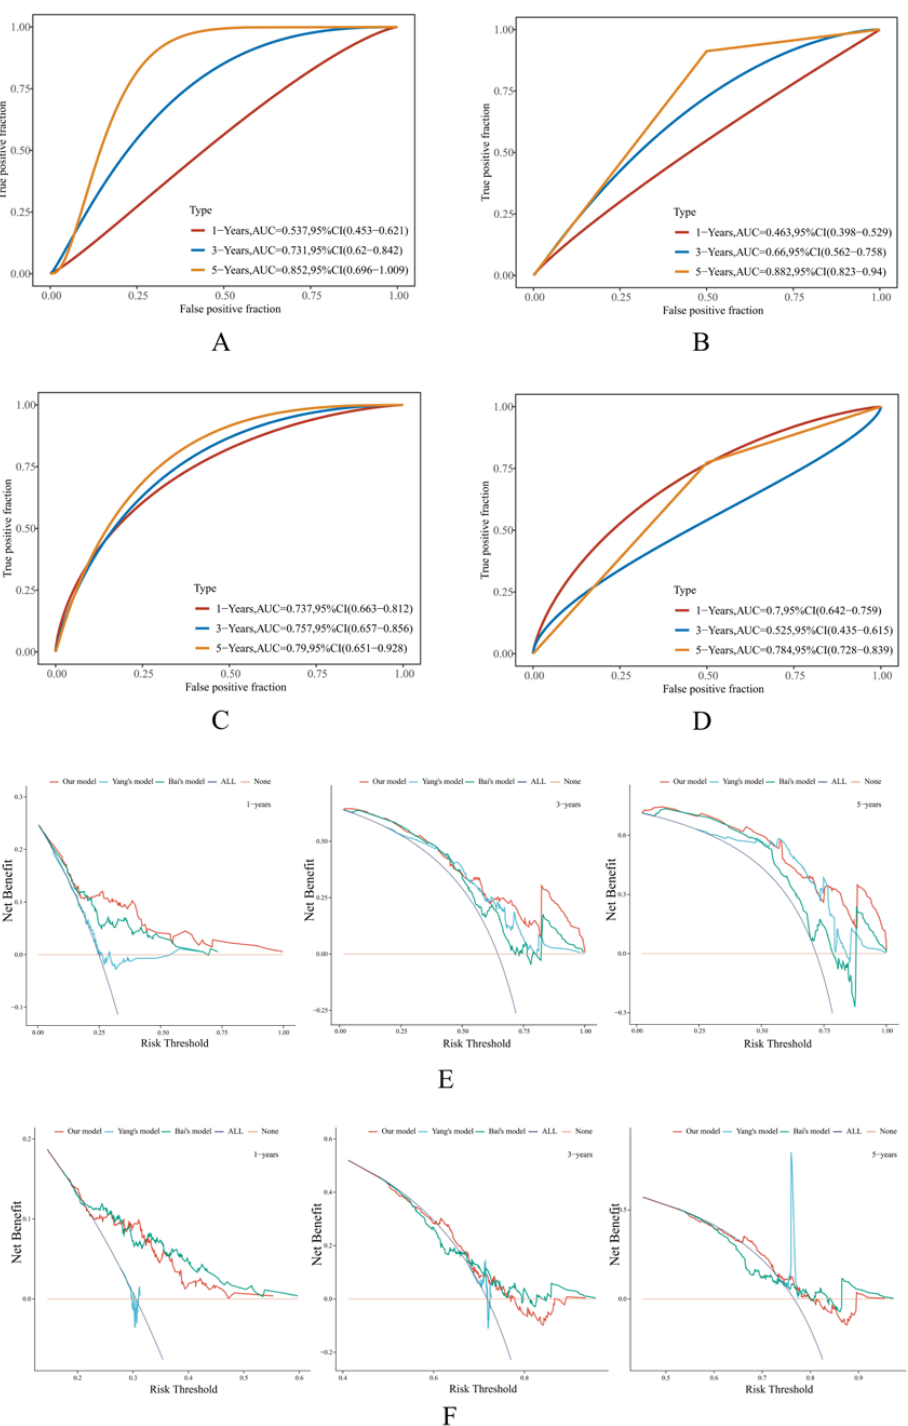
between the high- and low-risk groups classified by both models in the GSE62452 dataset, such analytics could not be conducted, while our model still worked robustly (Figure 3F).